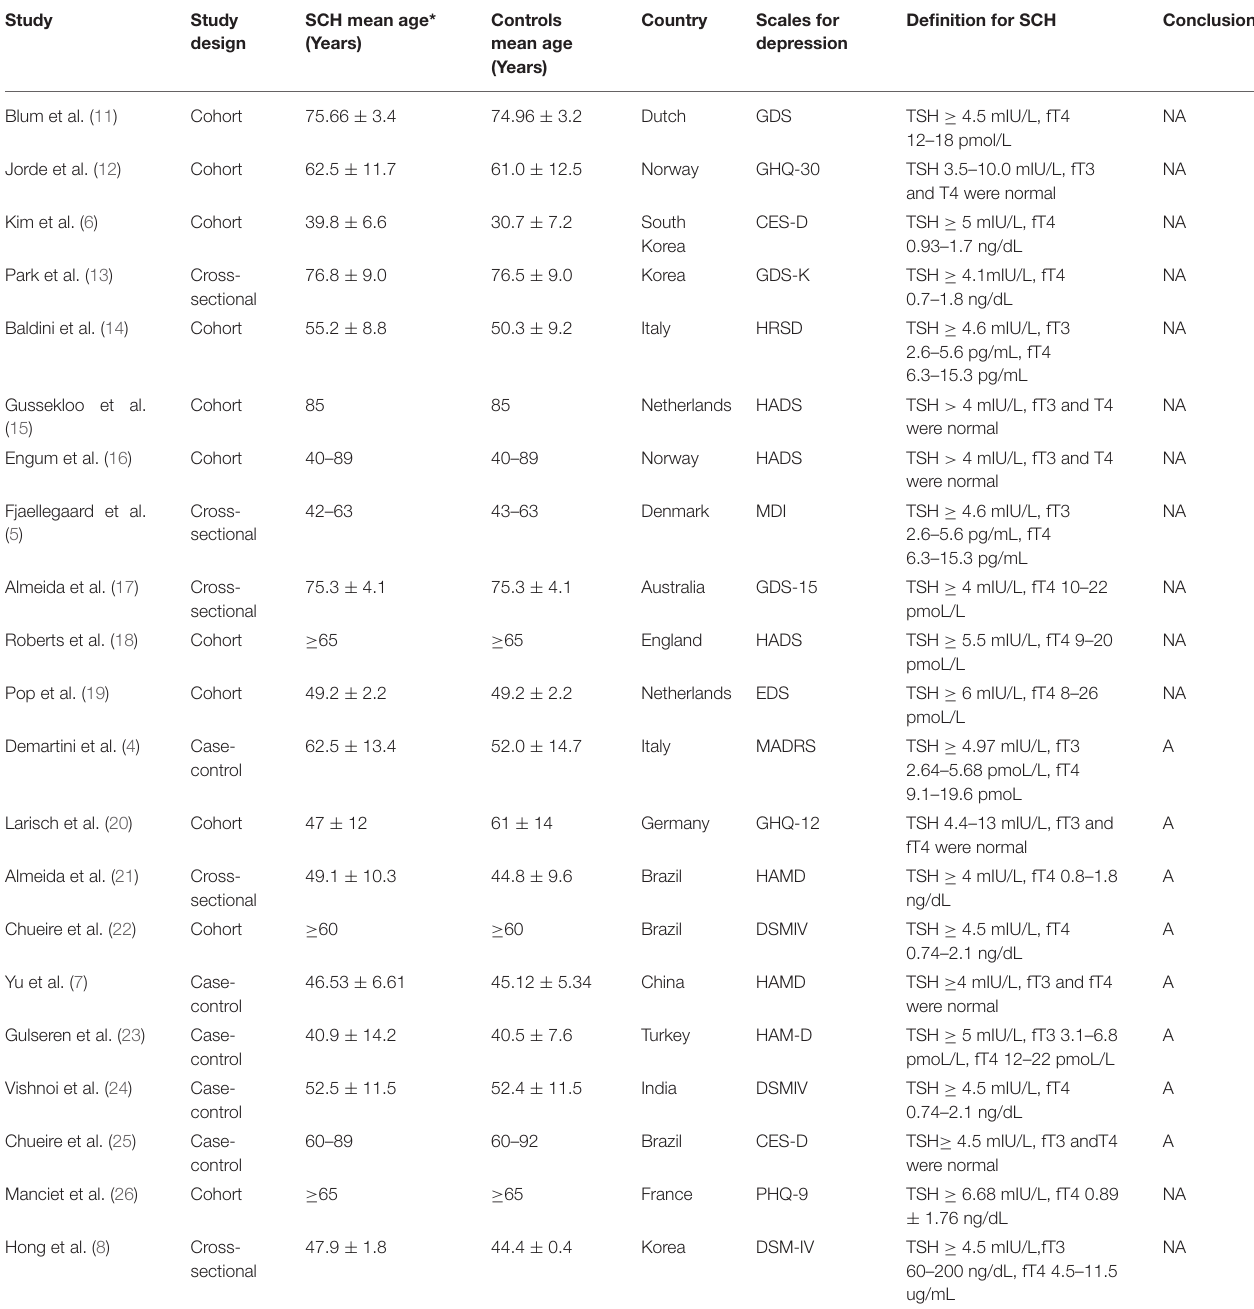
TABLE 1 | Characteristics of included